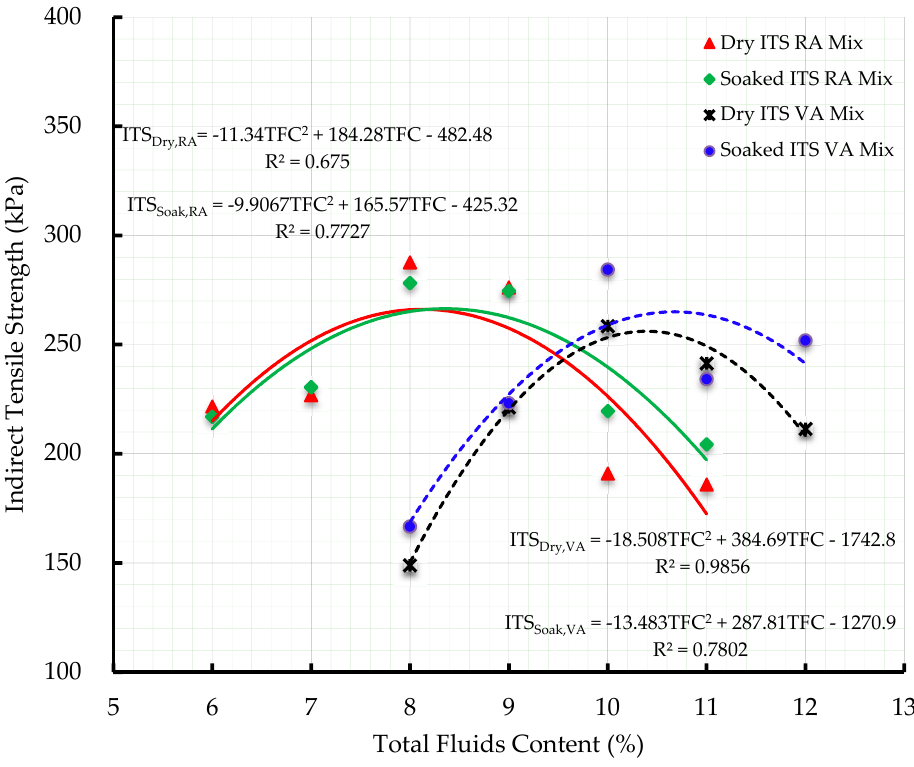
Figure 4. Indirect Tensile Strength for Virgin Aggregates and Reclaimed Asphalt Aggregates Mixes at Optimum Total Fluids Contents.